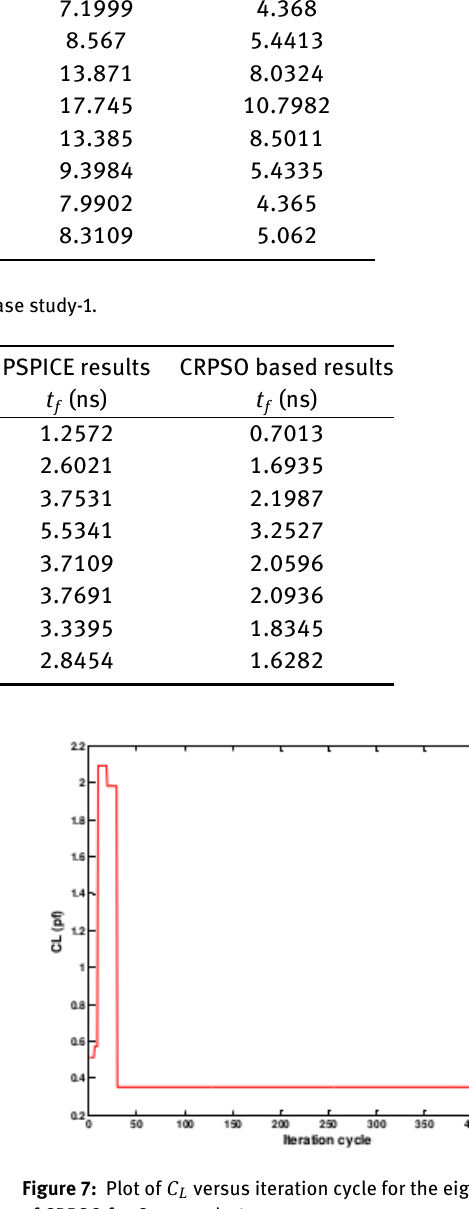
Figure 6: Plot of J versus iteration cycle for the eighth design set for Case study-3.